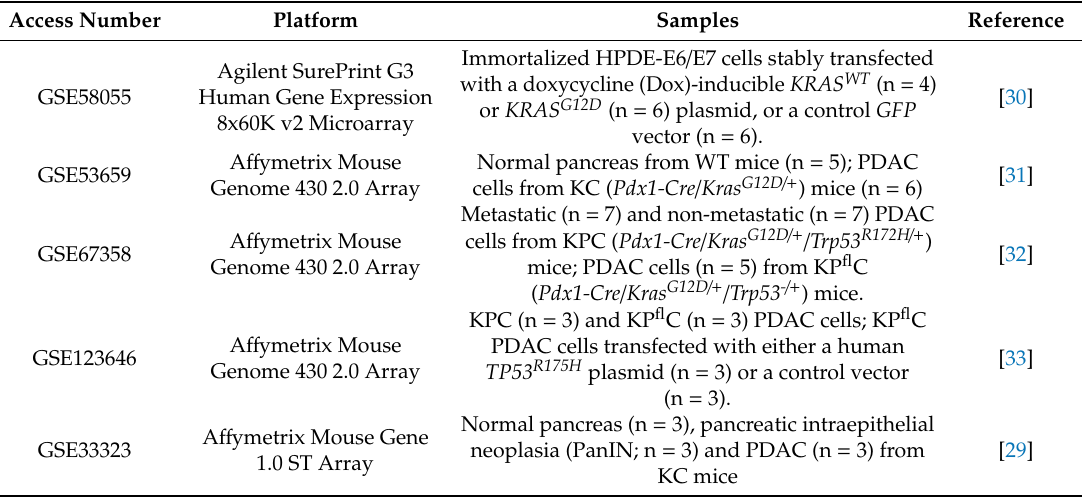
Table 3. Microarray data sets from KRAS -mutant and TP53 ( Trp53 )-mutant